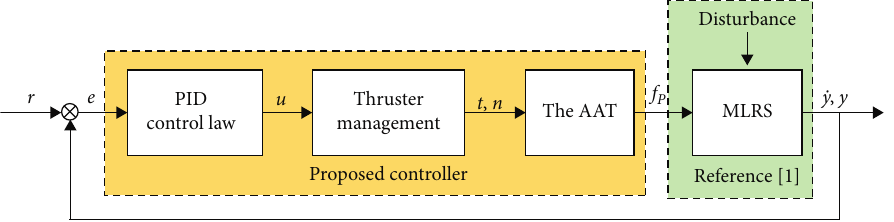
Figure 6: Simulation system for MLRS vibration control in the launching with the AAT.